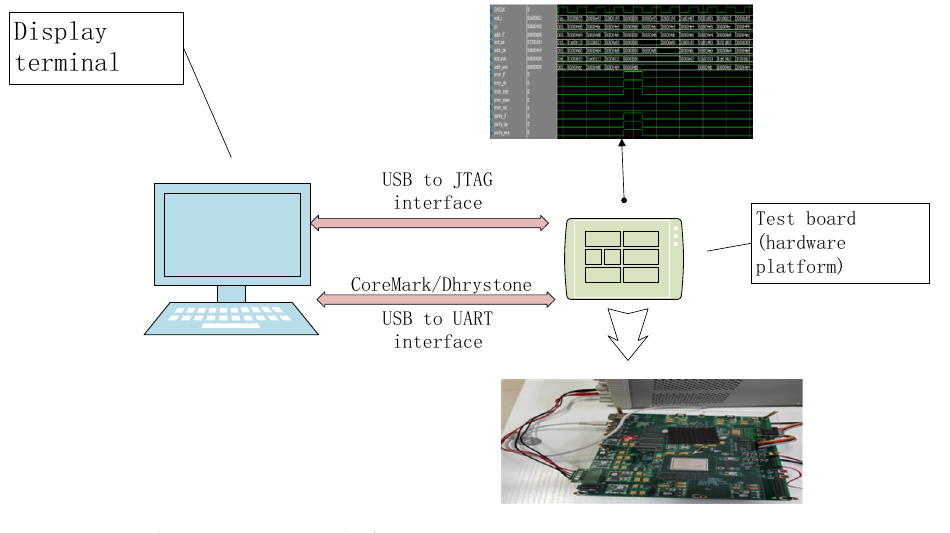
Figure 21. Hardware interaction platform.